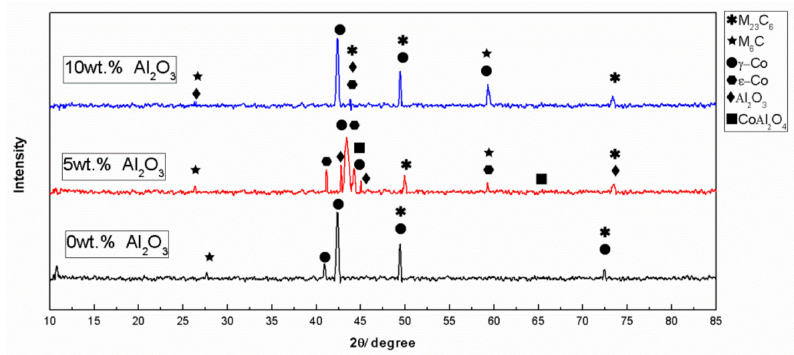
Figure 5. XRD patterns of the CoCr alloy sample with 0, 5, and 10% Al 2 O 3